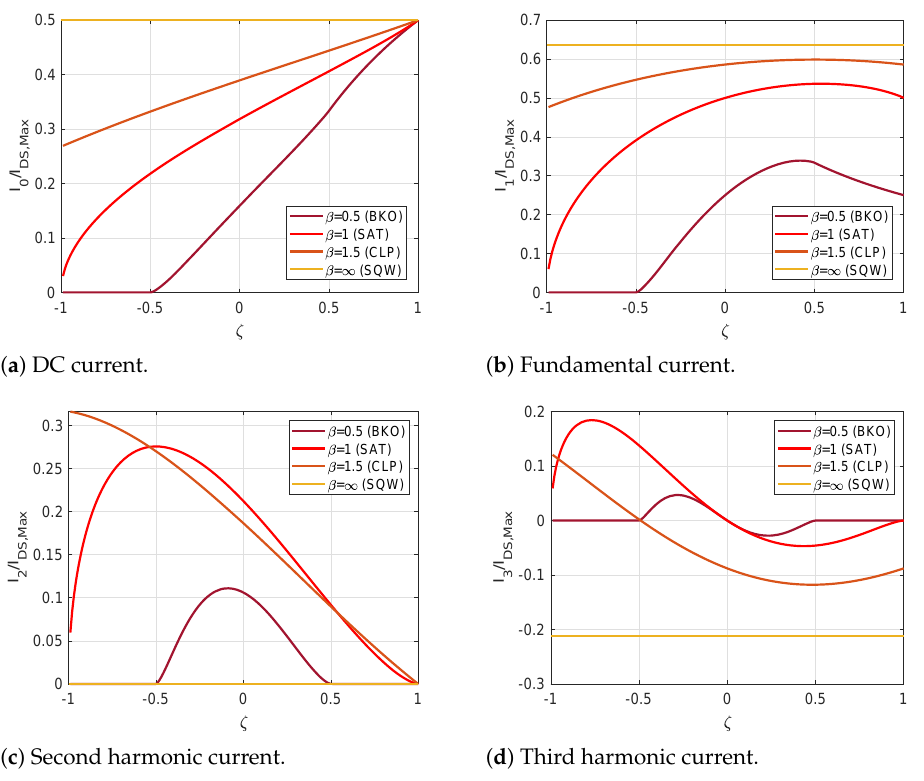
Figure 5. Normalized components of the drain-source current as a function of ζ .